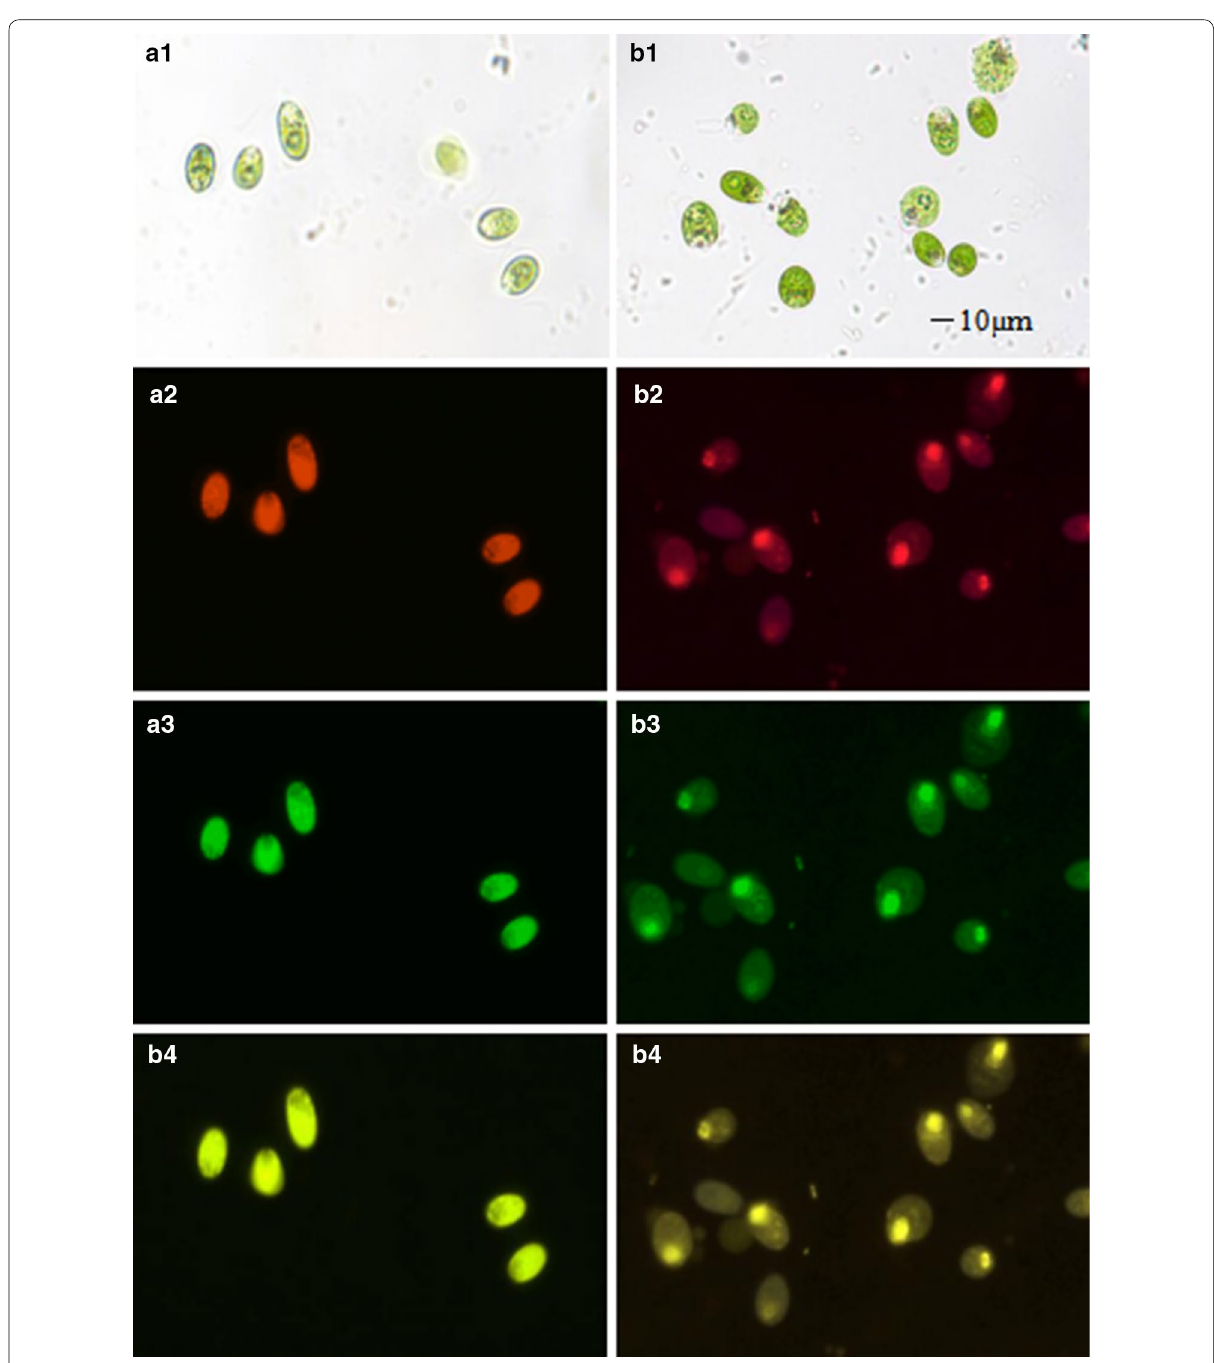
Fig. 2 a1 – a4 Represented the wild type D. salina cells under the light, red fluorescence (excitation wavelength 530–550 nm, emission wavelength 575–635 nm), green fluorescence (excitation wavelength 460–490 nm, emission wavelength 510–560 nm), and the merged fluorescence (red with green), respectively; b1 – b4 represented the stained D. salina cells under the corresponding mentioned above light and fluorescence